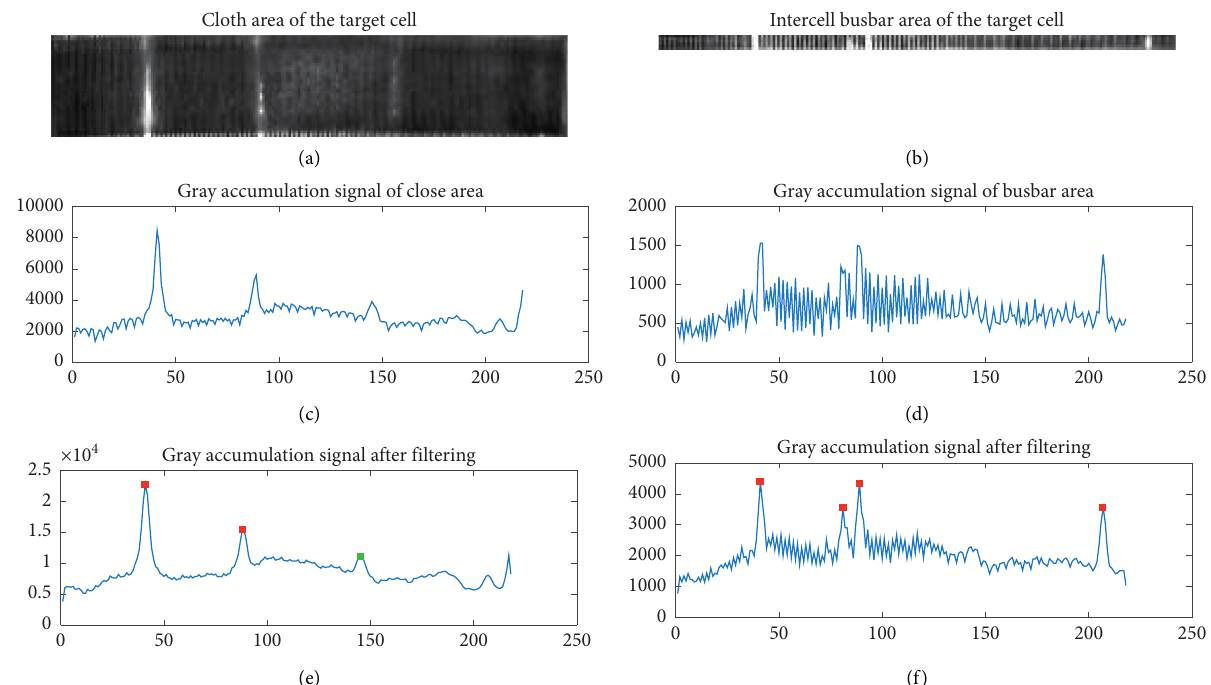
Figure 12: Gray accumulation signal of the cloth area and the intercell busbar